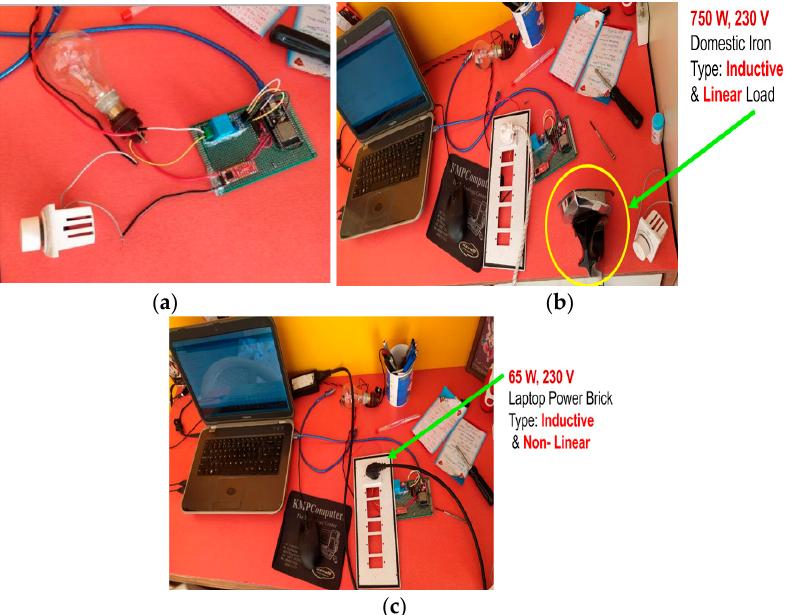
Figure 14. Hardware setups with three different loads: an ( a ) incandescent lamp, ( b ) electric iron box, and ( c ) laptop charger.